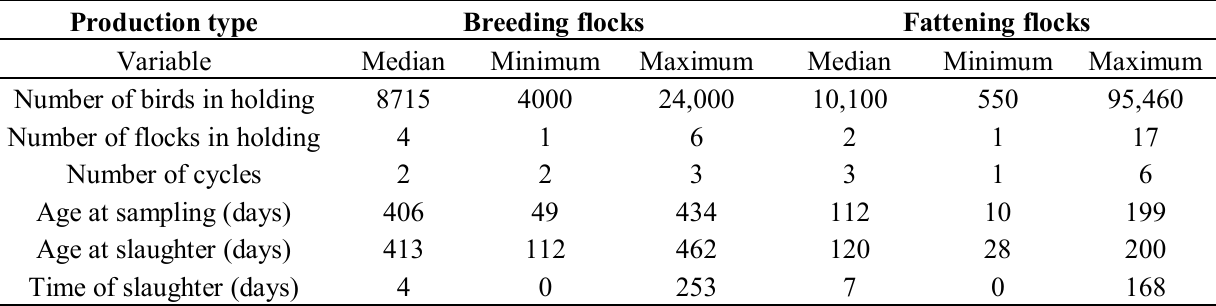
Table 3. Structure of turkey population covered in the baseline survey in